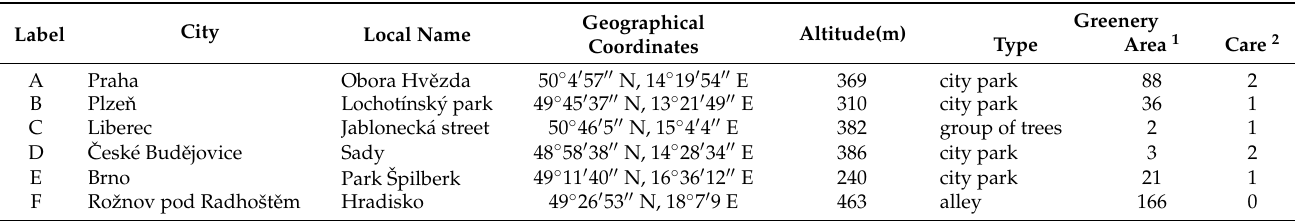
Table 1. Characteristics of the sampling